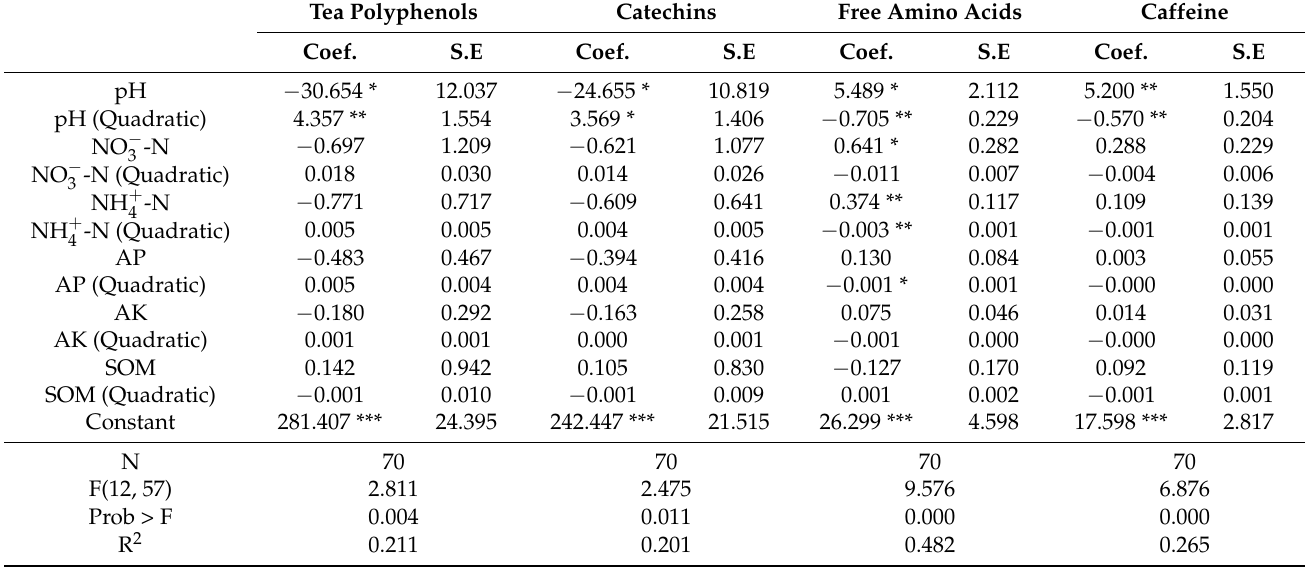
Table 3. Analysis of the influences of soil nutrients and soil pH on the main chemical component concentrations in tea. Tea Polyphenols